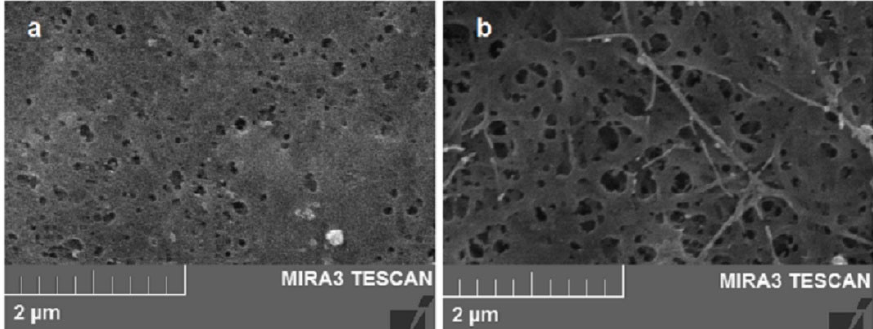
Figure 3. SEM images: ( a ) BC + MF sample with the lowest and ( b ) BC + NaCl sample with the highest specific area and pore volume.